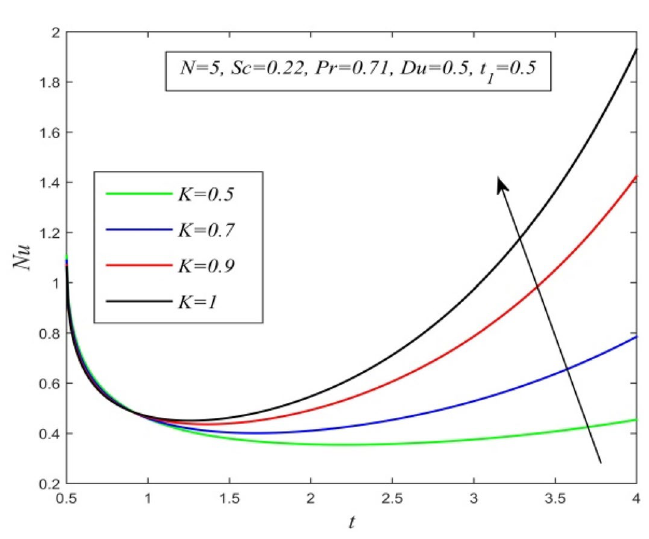
Figure 26. Nu versus t for different K and Sc = 0.22, N = 5, Pr = 0.71, Du = 0.5, t 1 =